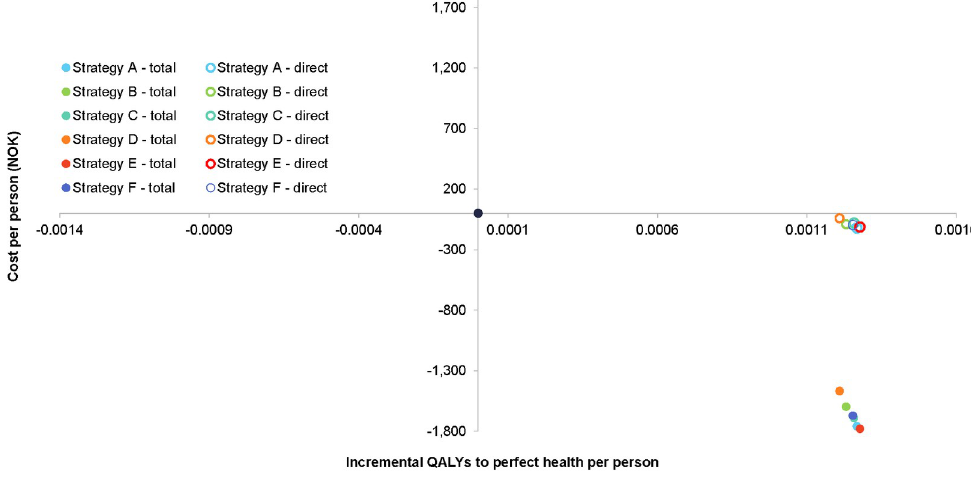
Fig 5. Cost-effectiveness of varicella vaccination from the health care system- and societal perspectives. Cost- effectiveness analysis from the perspectives of society (closed circles) and the health care system (open circles). Closed black circle represents no vaccine